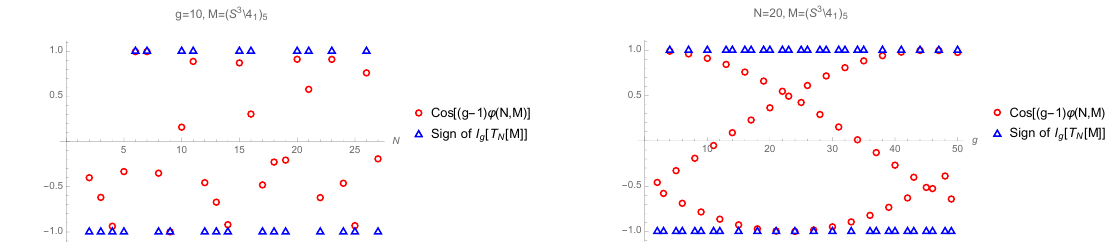
Figure 1 . Sign oscillation of I g [ T N [ M ]] with M = ( S 3 \ 4 1 ) as N varies with fixed g = 10 P/Q =5 (Left) or g varies with fixed N = 20 (Right). The blue triangle is the sign of I g [ T N [ M ]] , i.e. I g [ T N [ M ]] , while the red circle is cos (( g − 1) ϕ ( N, M )) . From the graph, one can see that twos | I g [ T N [ M ]] | have always the same sign. The I g [ T N [ M ]] is computed using the formula in (3.11) combined with (3.13) and the adjoint torsion computation summarized in appendix B. ϕ ( N, M ) is given in (3.19) with cs ( M ) = 1 . 52067 [54]. The undetermined O ( N ) part is numerically fitted and